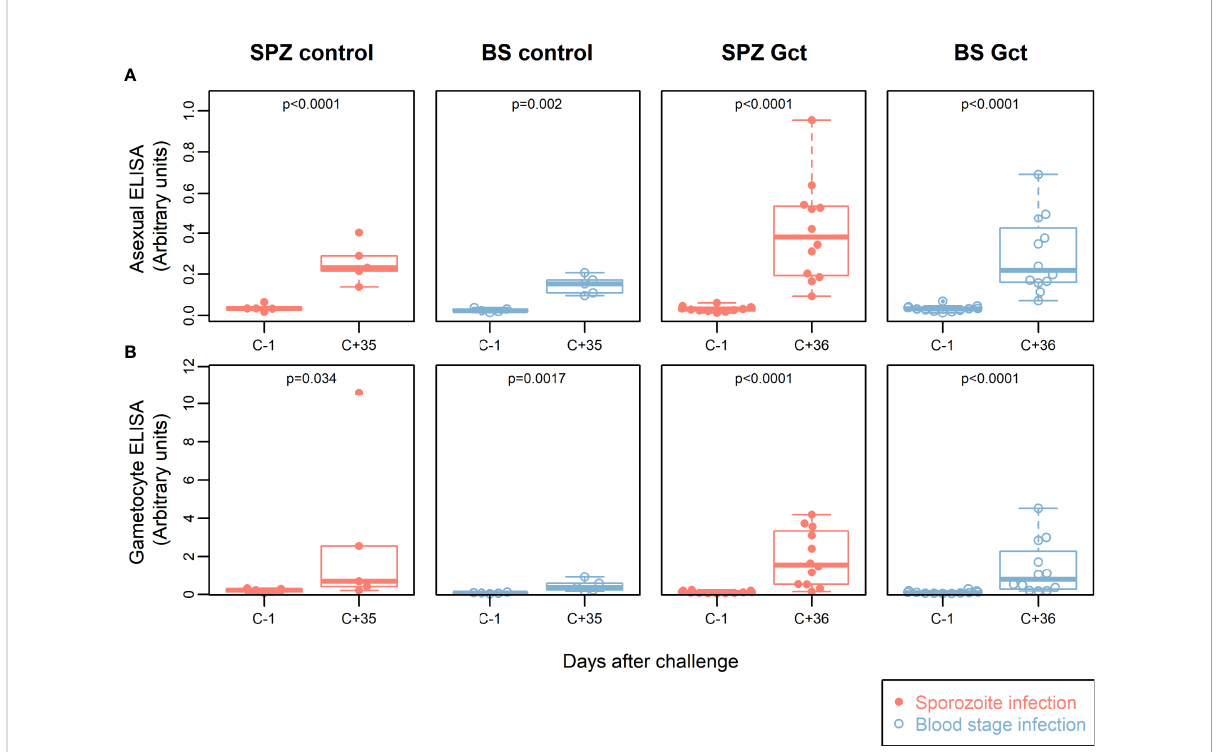
FIGURE 1 Participant parasite exposure and antibody response to crude parasite extracts. IgG antibody responses to crude asexual and gametocyte extracts. In all plots, red solid circles denote mosquito bite (sporozoite) infection cohorts (SPZ Control, SPZ Gct) and blue hollow circles denote asexual parasite infection (BS Control, BS Gct). (A) Anti-asexual antibody response pre- and post- (day 36) infection. (B) Anti-gametocyte antibody response pre- and post- (day 36) infection. p = p-values from paired t-tests on log-transformed